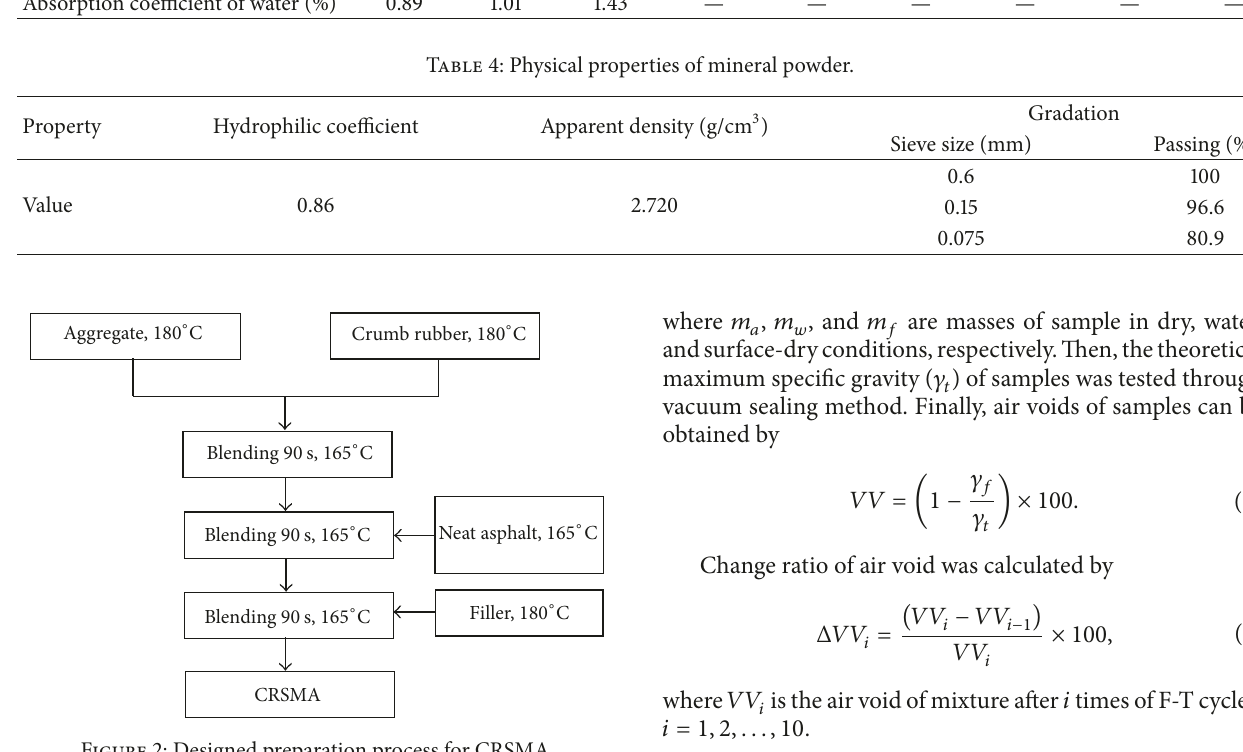
Figure 2: Designed preparation process for